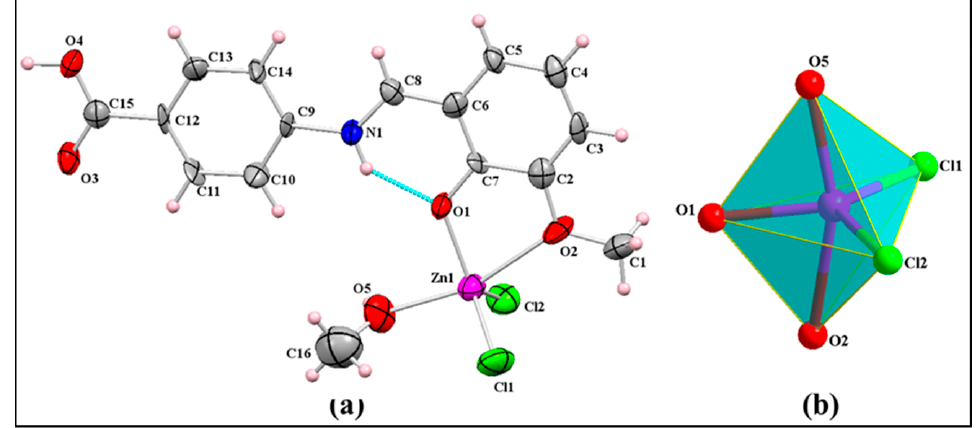
Figure 1. ( a ) ORTEP view of asymmetric unit of complex 1 at 70% probability level with labelled atoms. ( b ) A view of co-ordination environment around zinc(II) ion. Table 1. Crystal and structure refinement data for complex 1 .